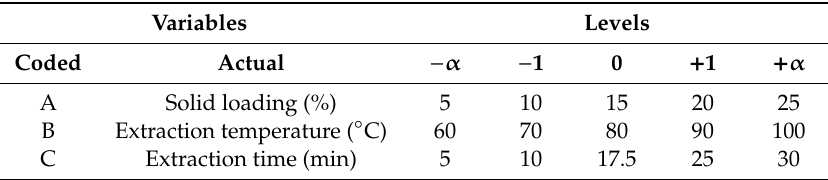
Table 7. Variables and levels involved in CCD